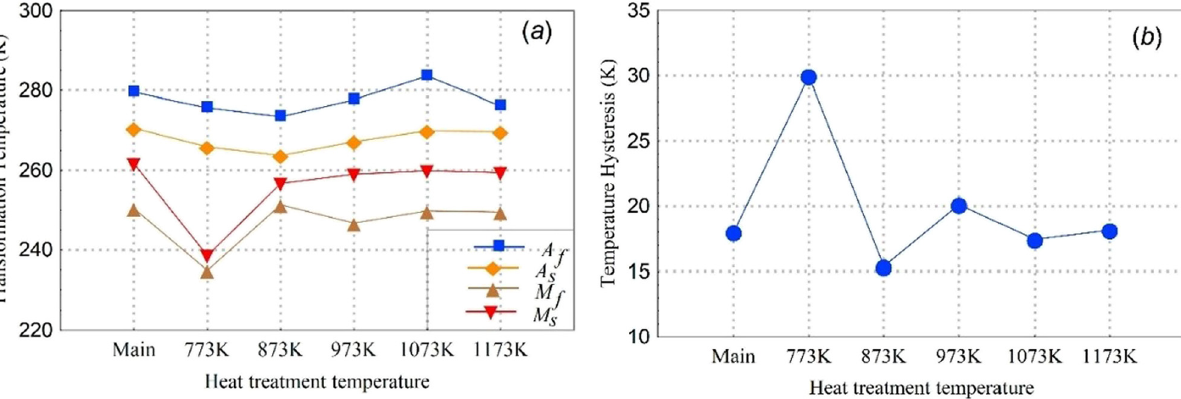
Figure 13: ( a ) Phase transition temperature of Cu – 13Al – 3Ni – 4Hf alloy at di ff erent temperatures and ( b ) temperature hysteresis for each case [ 123 ]